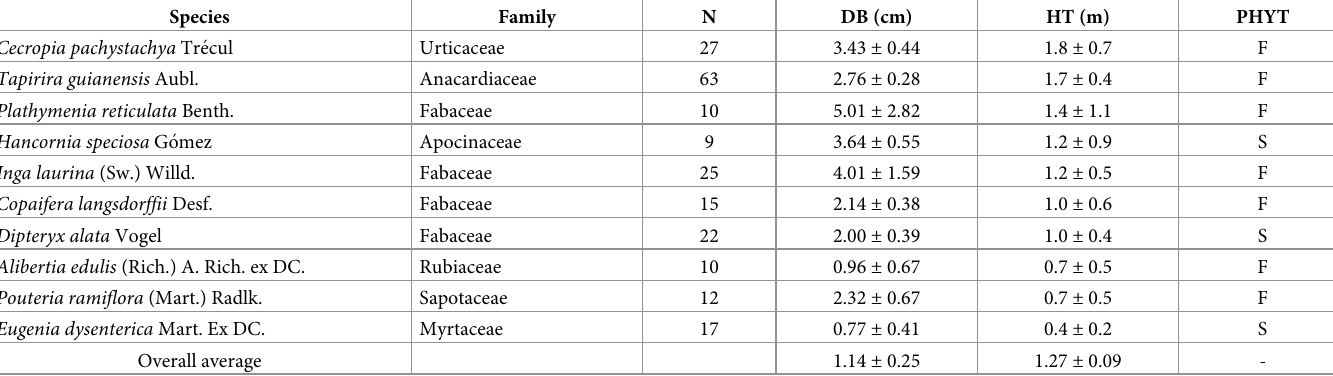
Table 1. Dendrometric characteristics of the 10 most abundant species recorded in the gravel during the restoration process, 6 years post-planting.